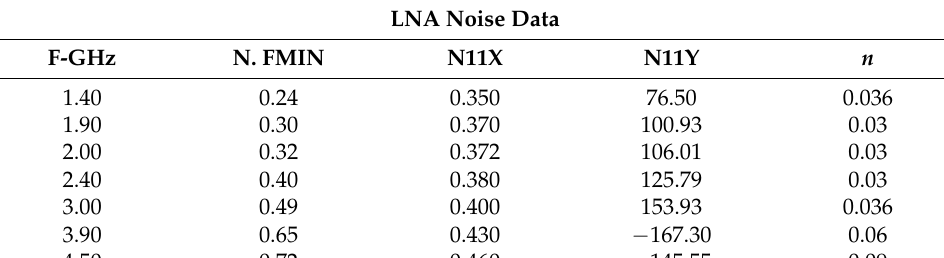
Table 5. LNA noise parameters at S band.